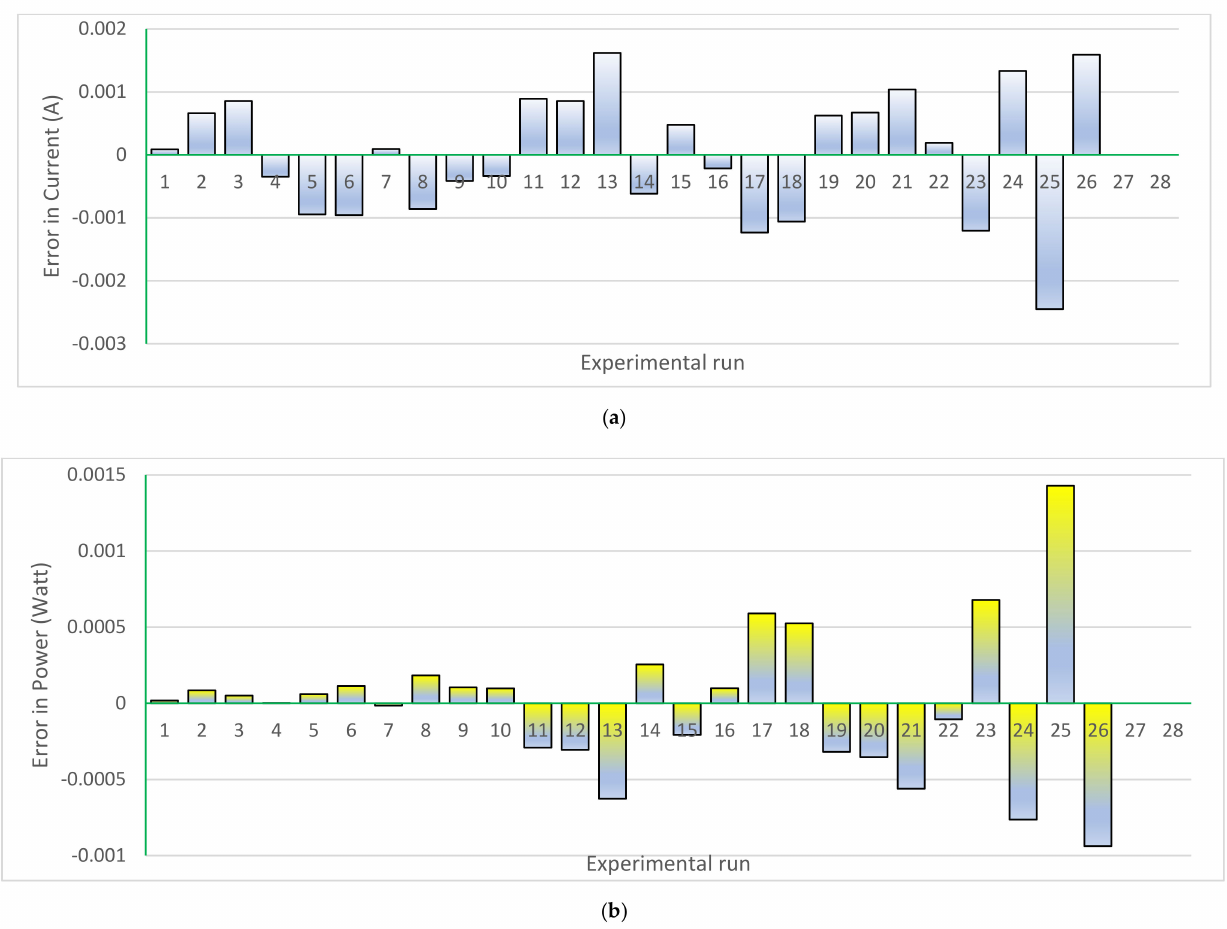
Figure 7. Error values for R.T.C. France SDM based on parameters extracted from TFWO: ( a ) Current error values and ( b ) power error